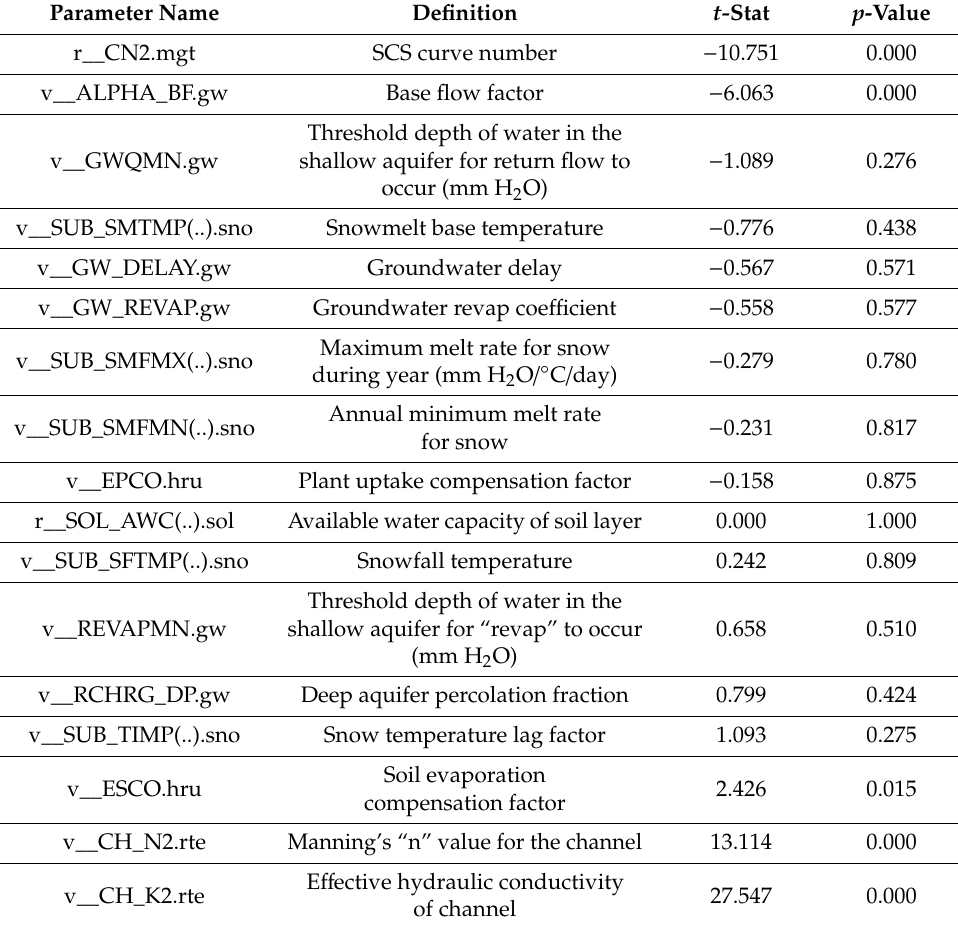
Table 3. Parameter sensitivity analysis.